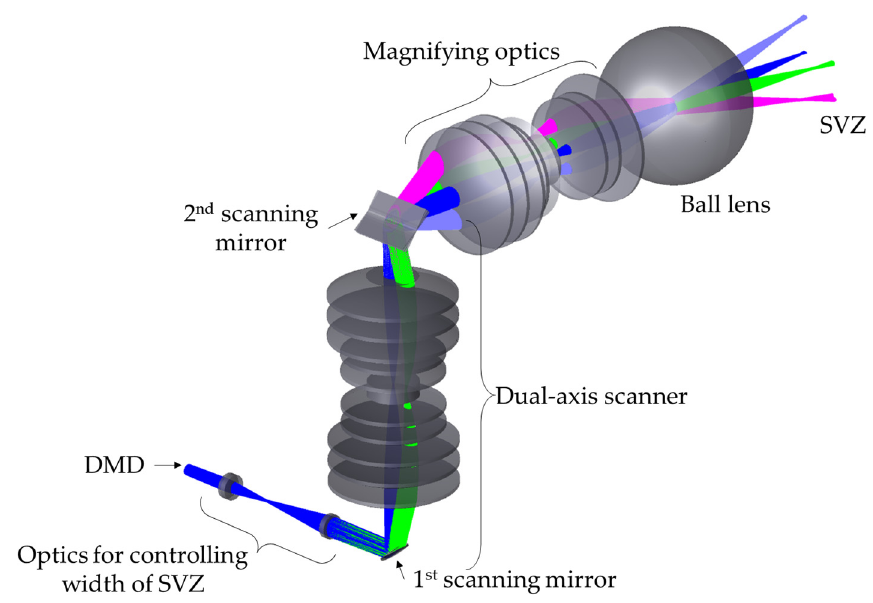
Figure 10. Optical structure of the proposed full parallax multiview display.